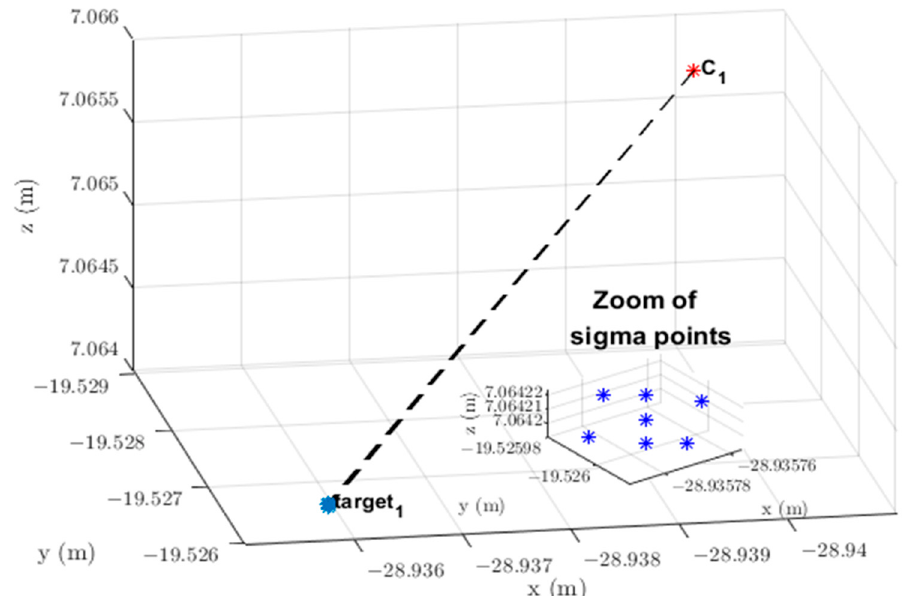
Figure 12. 7 Sigma points found after applying UT to noisy LoS vectors in the image plane (optical axis included) undergoing the proximity metric algorithm to determine the distance between vector constraint pairs and the corresponding set of points in 3D space with distribution 𝒩(cid:3435)𝜇 (cid:3033)(cid:3038) , 𝐶 (cid:3033)(cid:3038) (cid:3439) .